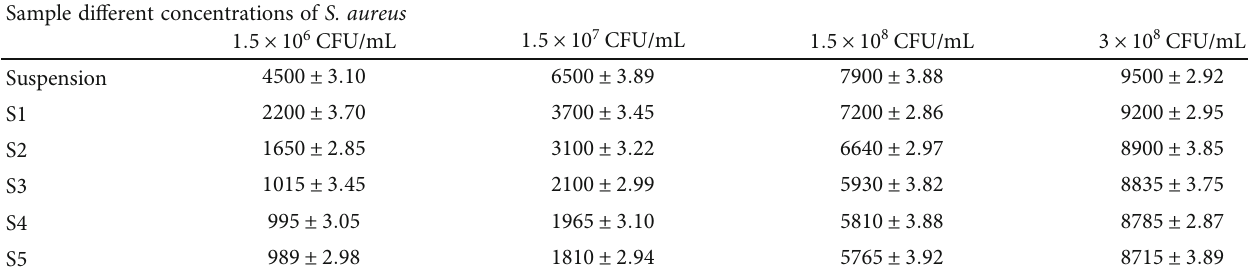
Table 2: Antimicrobial activity of various composite samples.